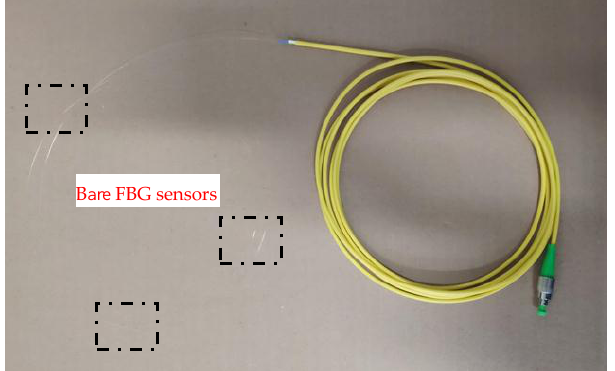
Figure 1. Fiber line with bare FBG sensors.